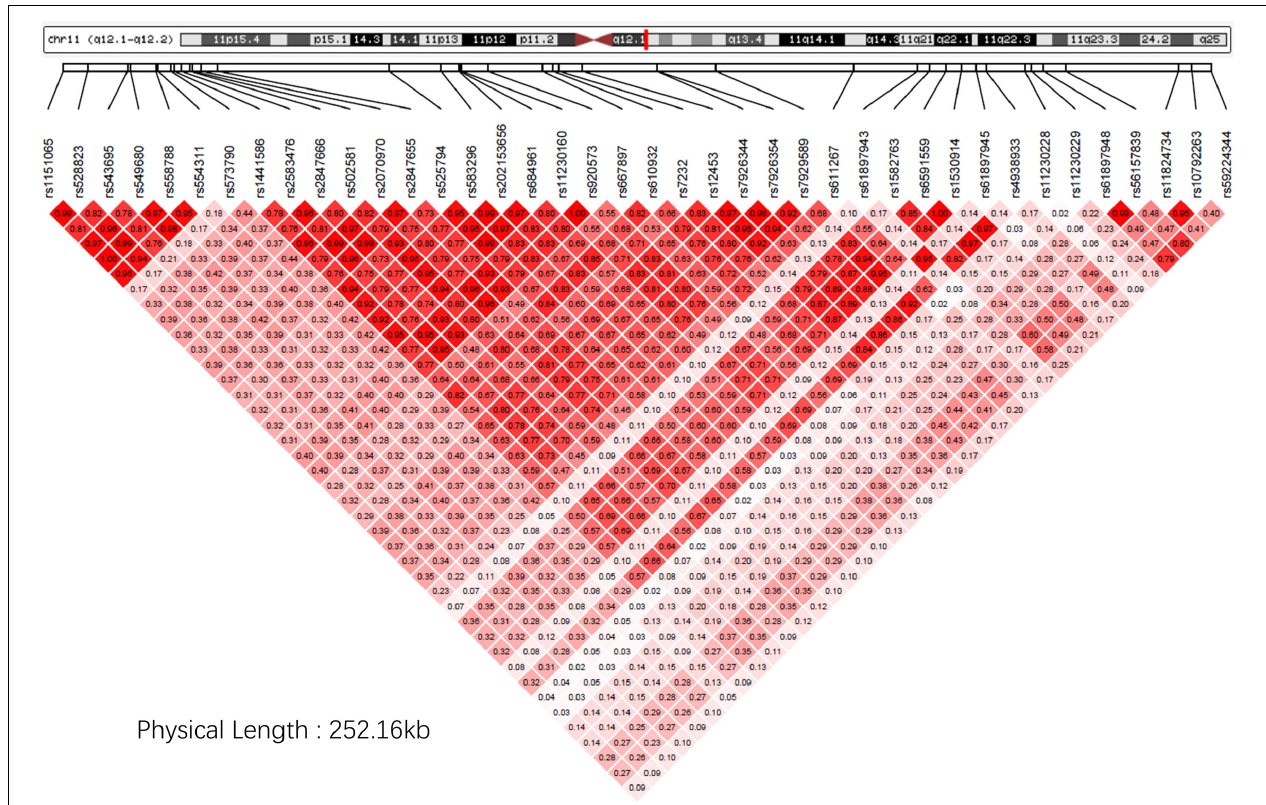
FIGURE 3 | The linkage disequilibrium pattern for the identified SNPs close to rs7232 in our study. Here the LD measure is r 2 .